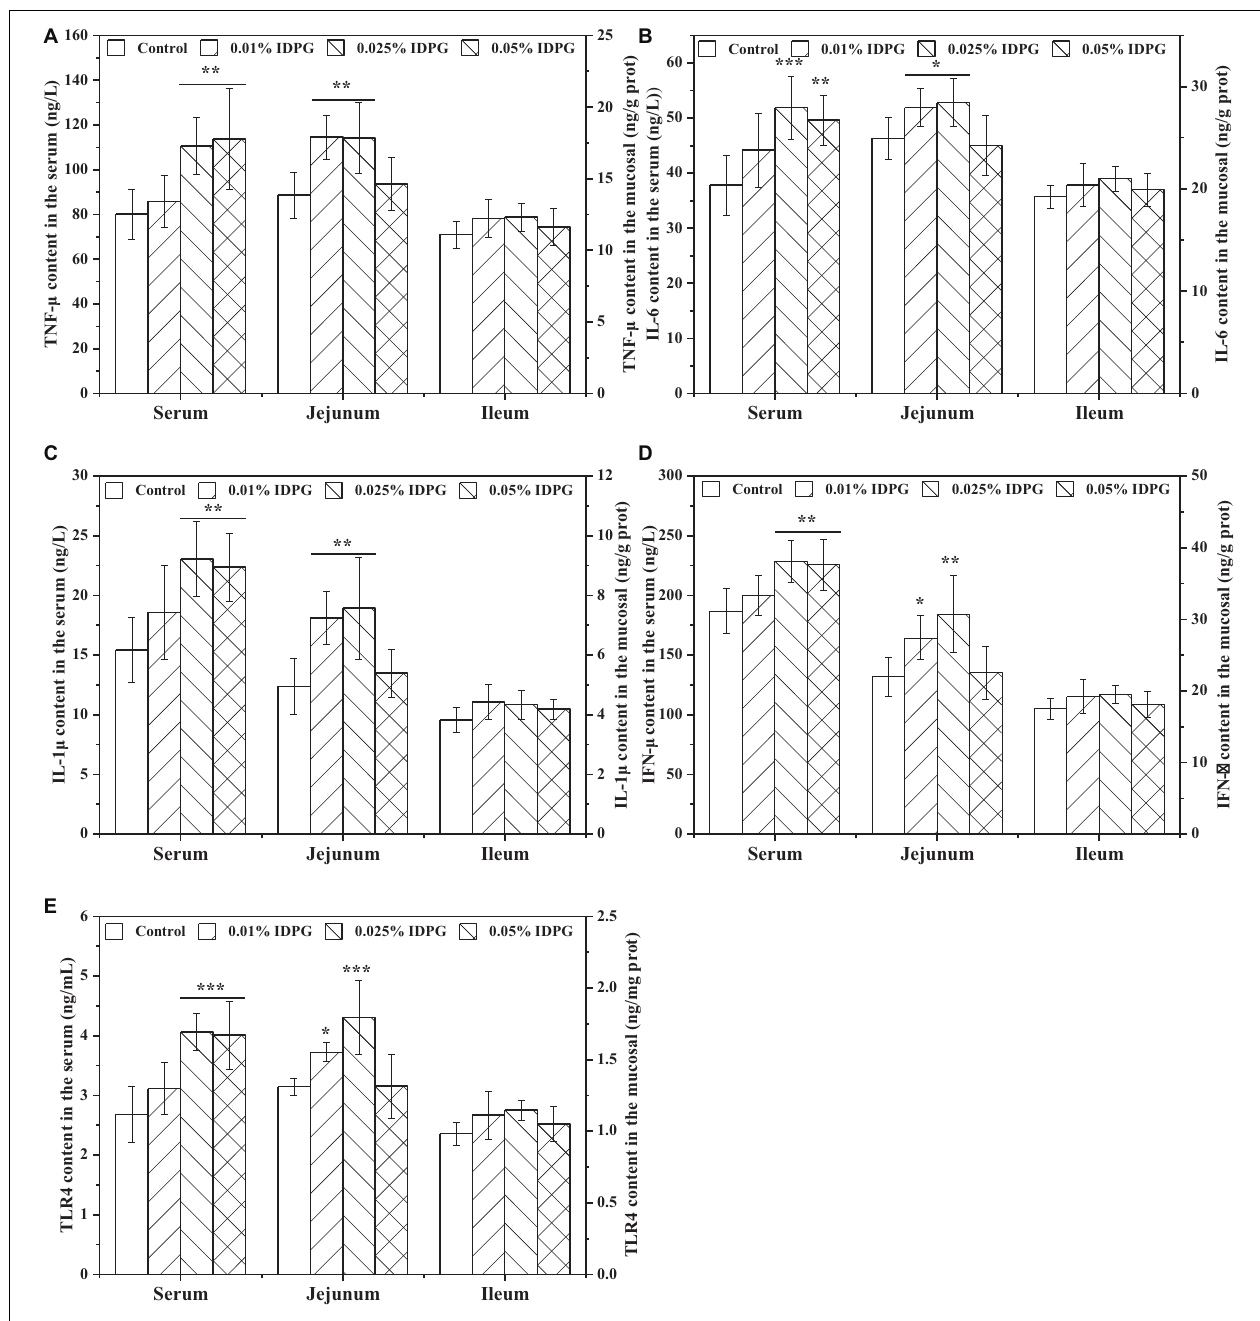
FIGURE 6 | Effects of incomplete degradation products of galactomannan (IDPG) on the secretion of tumor necrosis factor- α (TNF- α ) (A) , interleukin 6 (IL-6) (B) , IL-1 β (C) , interferon γ (IFN- γ ) (D) , and toll-like receptor 4 (TLR4) (E) in the serum, jejunum and ileum of laying hens. * P < 0.05, ** P < 0.01, and *** P < 0.001 compared with control group in each